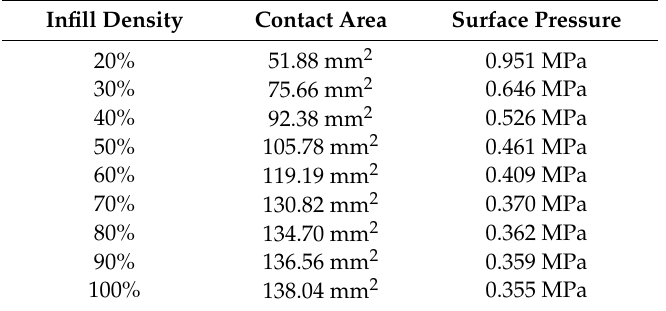
Table 2. Conversion of the infill density into the corresponding surface